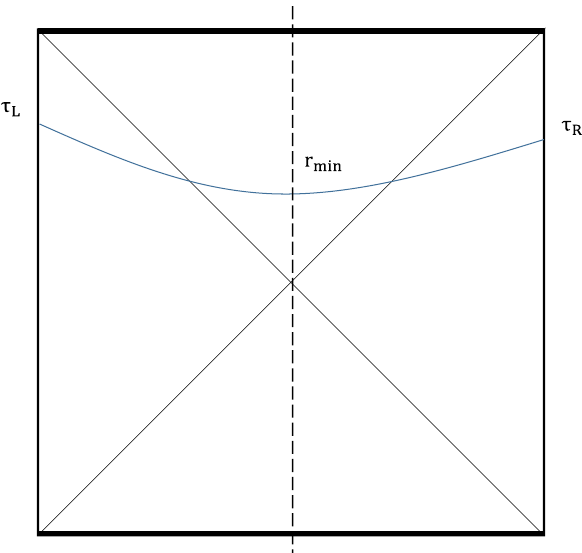
Fig. 3 “Complexity equals volume” (CV) duality for the eternal AdS blackholedualtotheboundarystate.Thebluecurvedenotesaspacelike surface which has maximal volume (generalized